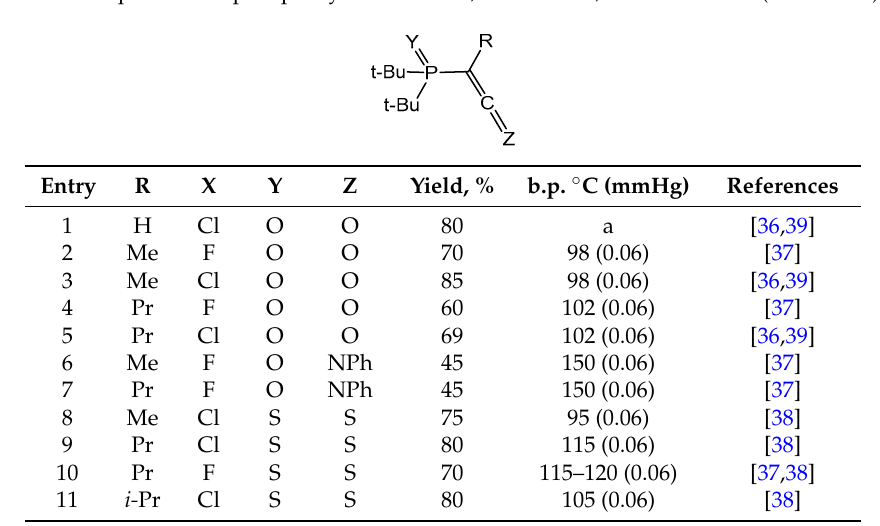
Table 9. Preparation of phosphorylated ketenes, thioketenes, ketenimines 48 (Scheme 31).